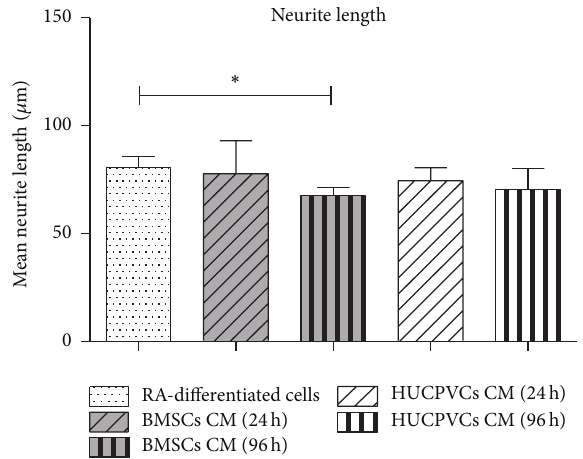
Figure 4: Quantitative analysis of SH-SY5Y neurite outgrowth seven days after incubation with BMSCs and HUCPVCs